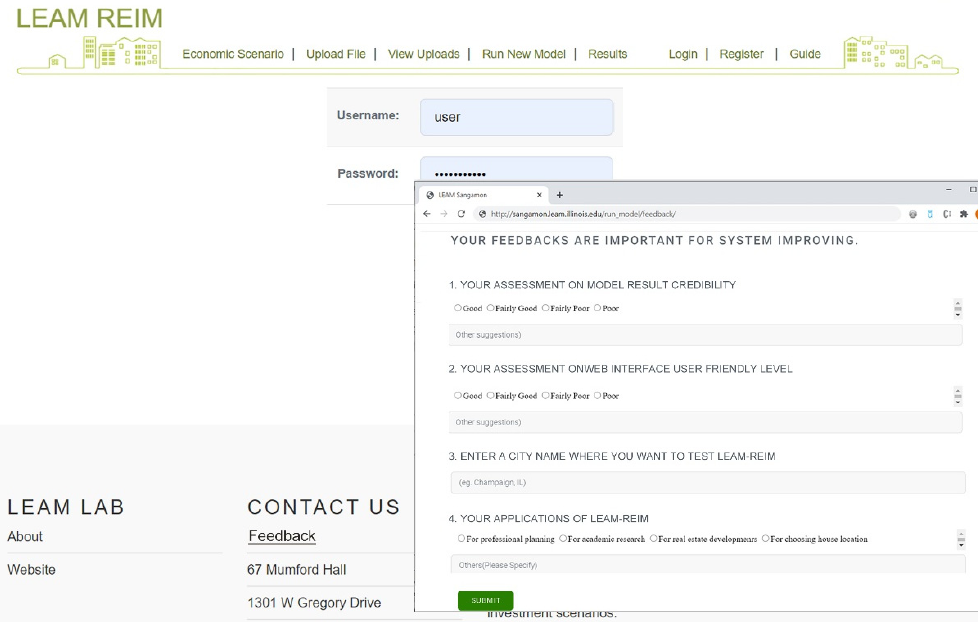
Figure 4. LEAM-REIM interface for running a model. To prepare for a model run, users name the scenario, write the scenario descriptions, upload a REIM model result as investment scenario, and select attraction characteristics.